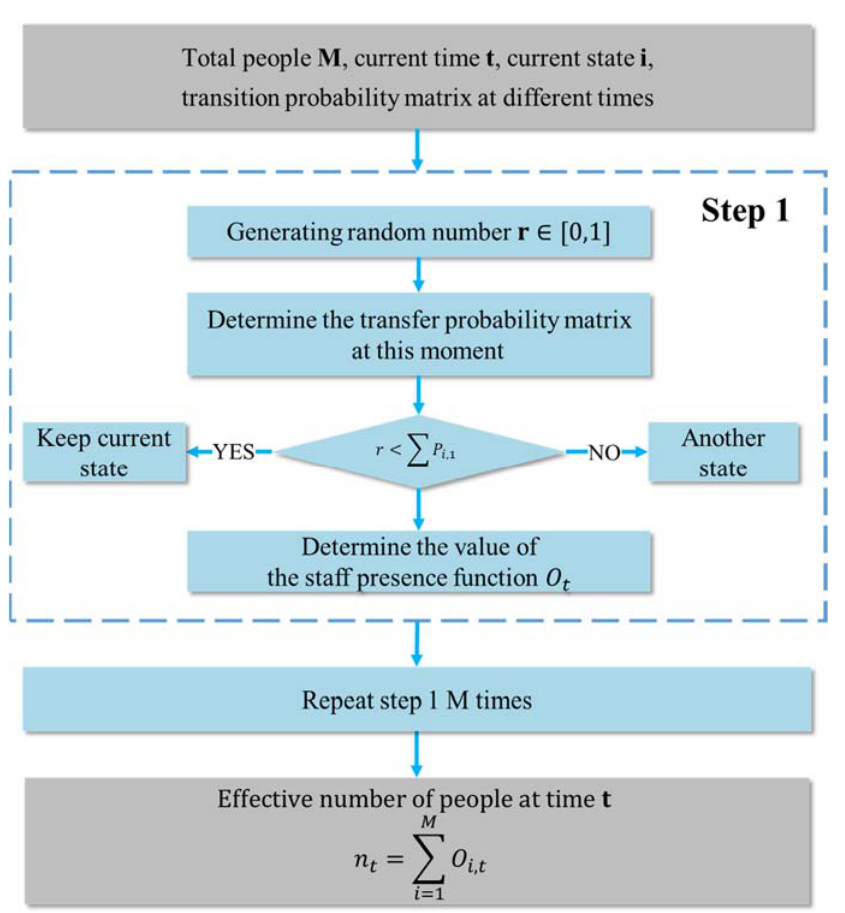
Figure 3. Algorithmic process to determine the effective number of people.